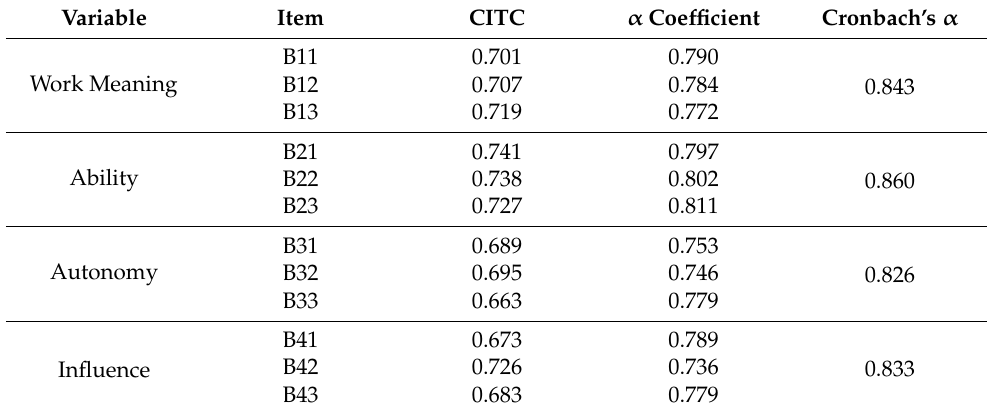
Table 6. Reliability Analysis of Psychological Empowerment.